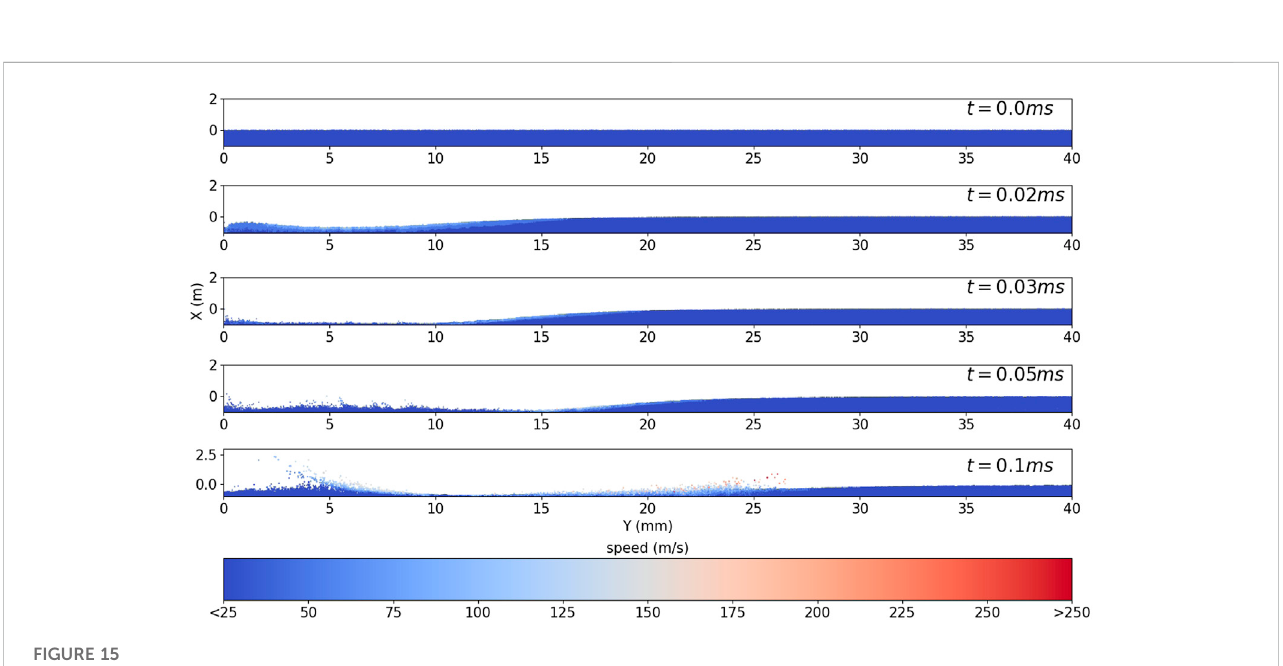
Regolith layer evolution with the stochastic model: